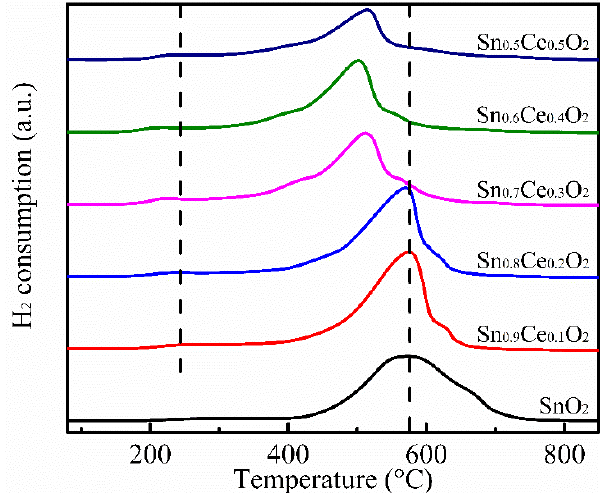
Figure 7. H 2 -TPR profiles of the SnO 2 and Sn x Ce 1-x O 2 fiber catalysts.